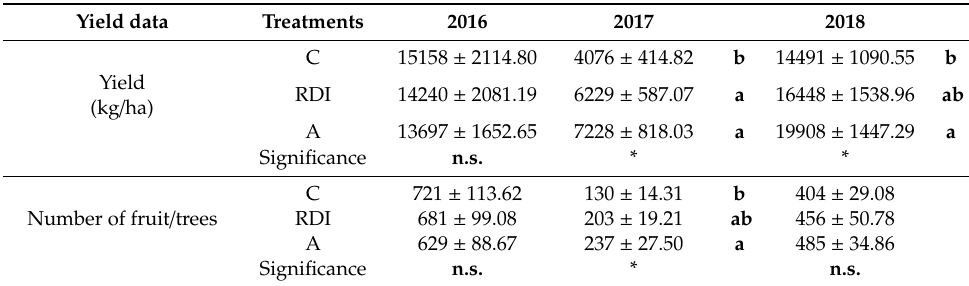
Table 4. E ff ects of irrigation on annual yield and number of fruits per tree in 2016, 2017, and